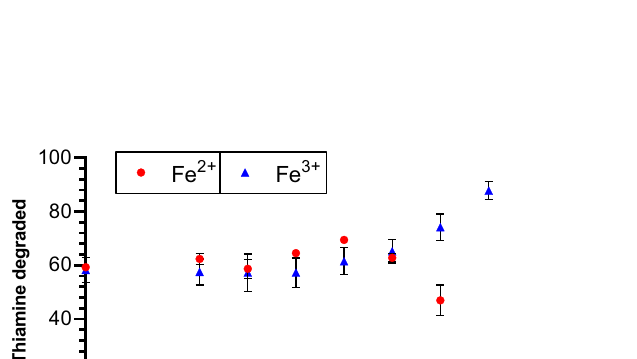
Figure 5. ( a ) Commercial vitamin B1, B-complex, and multivitamin simulated gastric fluid extracts diluted to theoretical 1 µM thiamine and incubated with (green) 0 µg/mL thiaminase and 0 µM pyridoxine, (blue) 0 µg/ mL thiaminase and 100 µM pyridoxine, (black) 0.33 µg/mL thiaminase and 0 µM pyridoxine presence and (red) 0.33 µg/mL thiaminase I and 100 µM pyridoxine at 37 °C for 2 h prior to oxidation with alkaline potassium ferricyanide and fluorescence measurement using 360/40 nm excitation, 450/50 nm emission. Each point and error bar represents the average and standard deviation of triplicate fluorescence measurements. ( b ) Data represented as percent thiamine degradation.